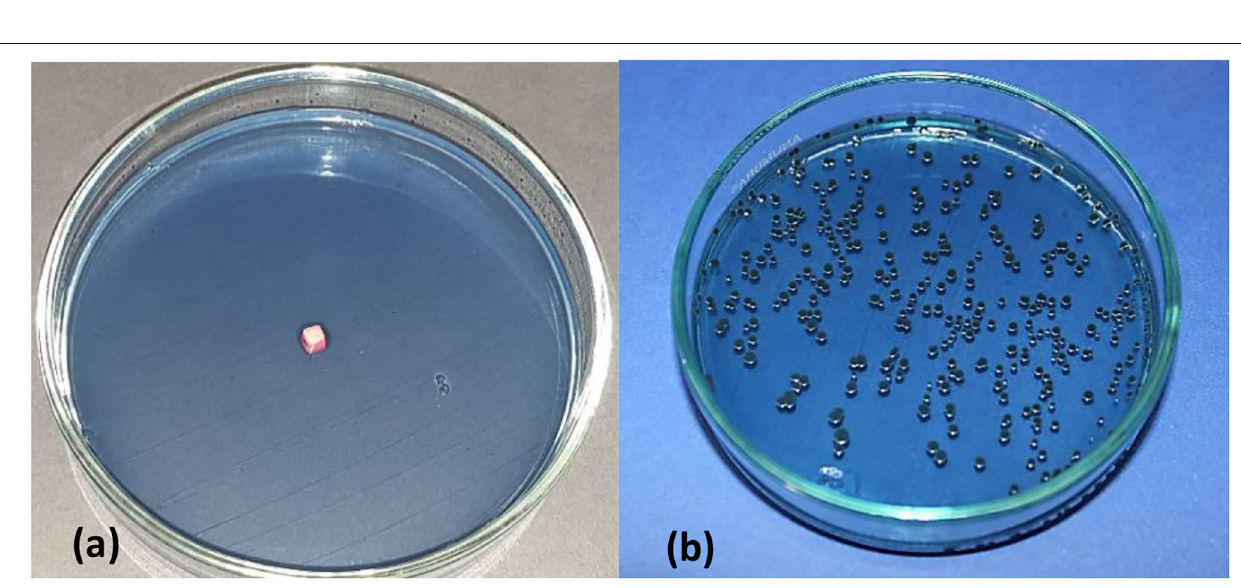
FIGURE 5 | Mitis salivarius containing petridish, showing treated enamel block sample covered with a thin layer of S. mutans bacterial suspension (a) , viable count of S. mutans following vortexing of enamel block, serial dilution and incubation for 18–24h (b) .